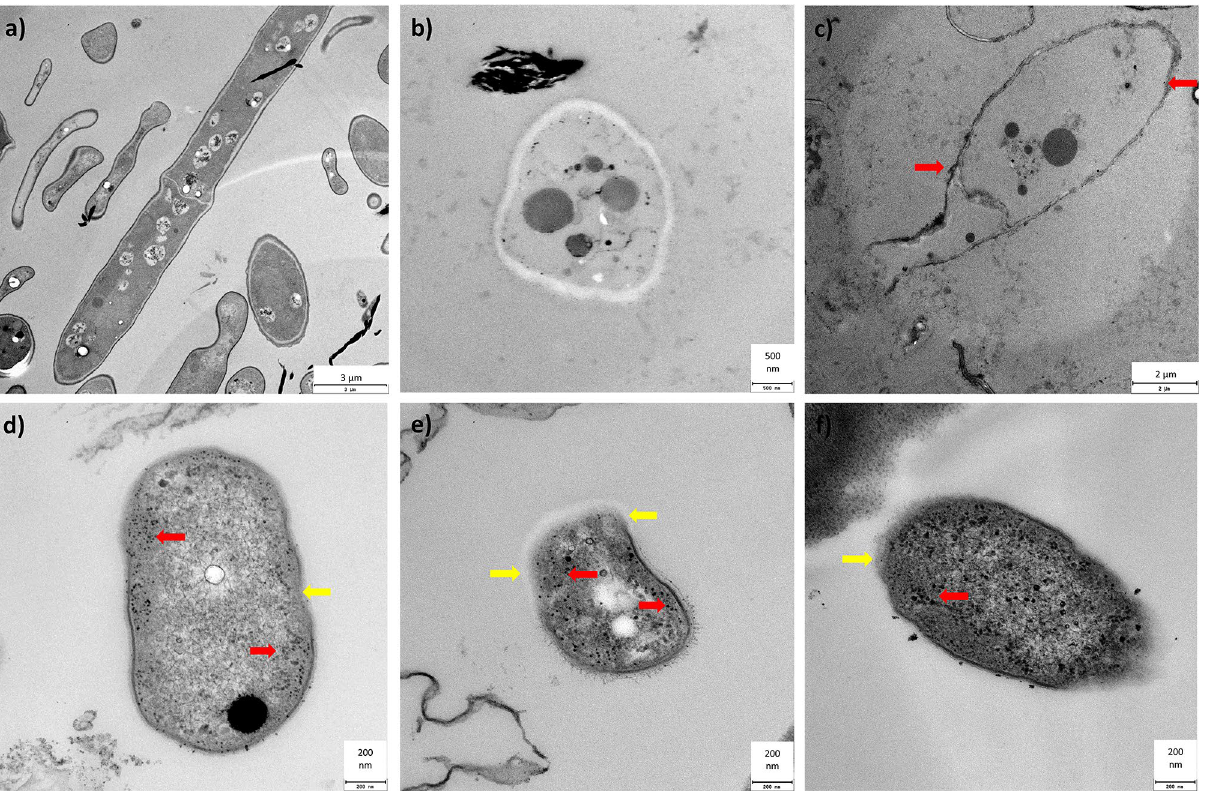
Figure 7. TEM micrographs of F. avenaceum conidia treated with water (control) ( a ), silver ions ( b ), TCSB- AgNPs ( c ), CHSB-AgNPs ( d , e,f ) at a concentration of 10 mg L −1 after culture for 240